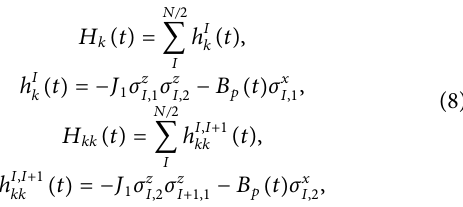
(cid:3) √ 2 is chosen for easier